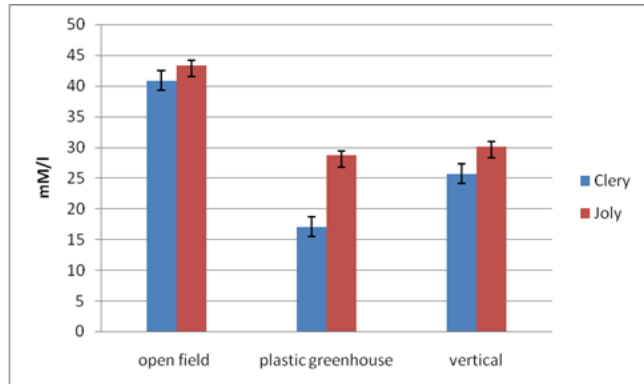
Figure 2. The average antioxidant values in 2017 in the case of the three cultivation technologies. Comparing the results got in 2016 and 2017 significant differences were found in the case of all three cultivating technologies in the case of two breeds (p=0.000). In the case of vertical, plastic greenhouse and open field technology and in the case of the control breed ‘Clery’ and the experimental breed ‘Joly’ the year 2017 showed better